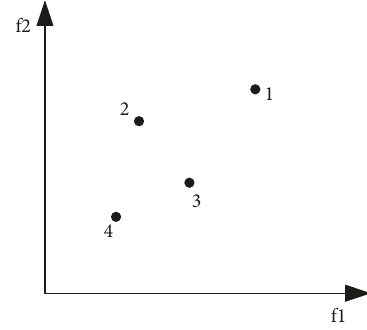
Figure 15: Dominant and nondominant solutions.